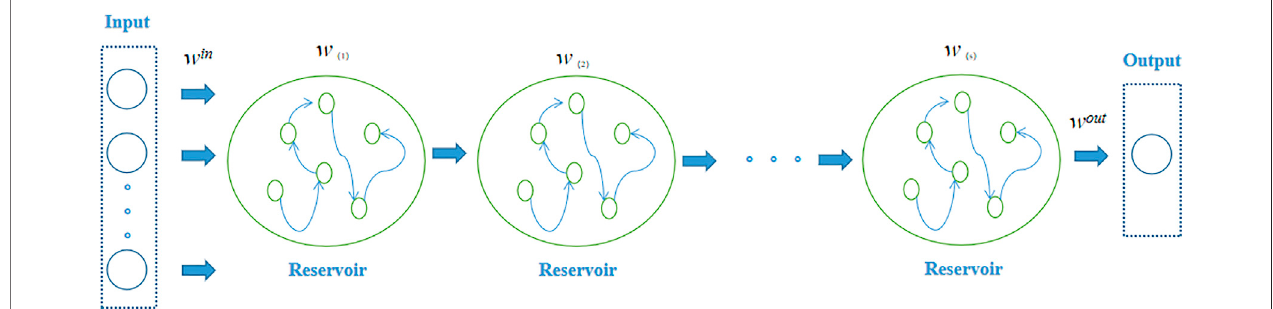
FIGURE 1 | Architecture of a